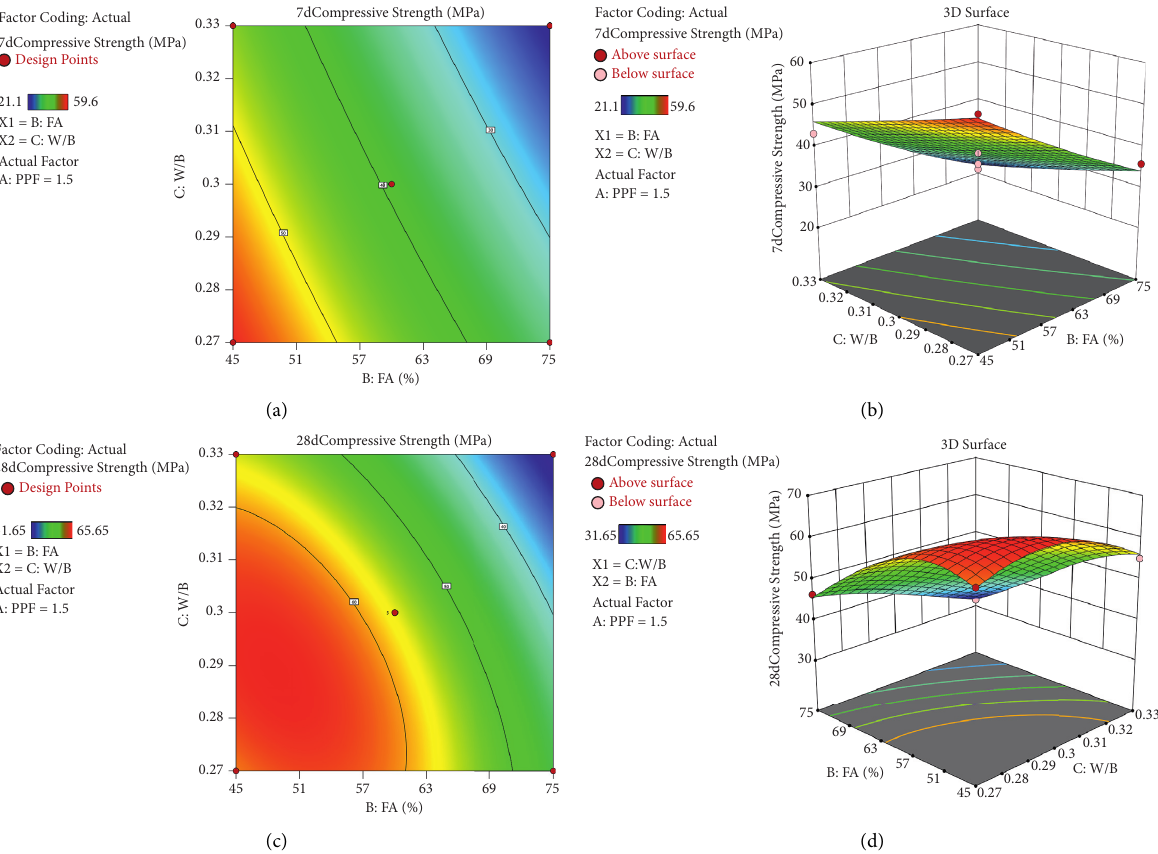
Figure 12: Contour plots. (a, b) 7d compressive strength. (c, d) 28 d compressive